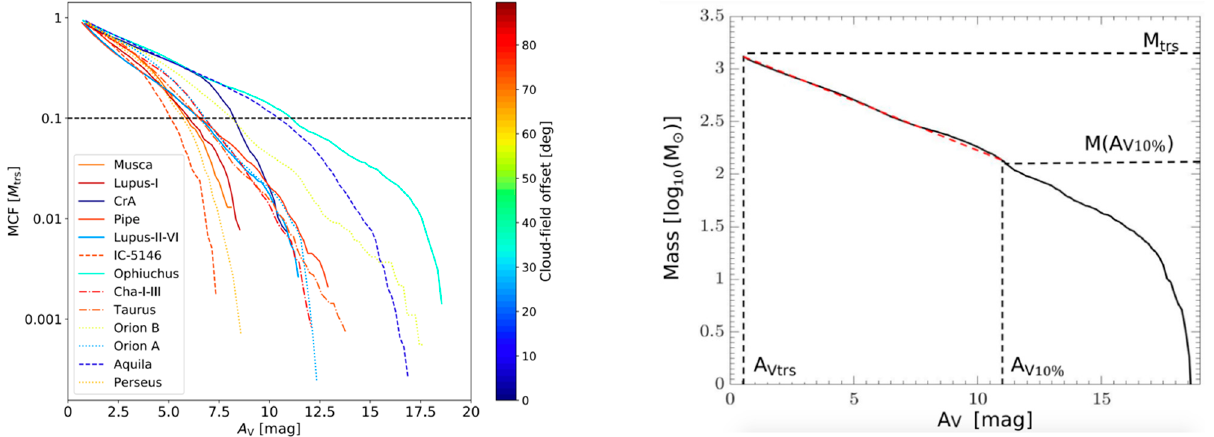
Figure 8. ( Left ): MCFs of all the Gould Belt clouds [34]. The MCFs are color coded by the cloud-field directional offsets. The starting point of each MCF is defined by the corresponding A V trs of the cloud. Perseus and Orion A/B are noted in dotted lines, because they have higher discrepancies of magnetic field directions inferred from optical and from PLANCK polarimetry data (Figure 6). Note that MCFs from smaller cloud-field offsets are in general shallower, which is further demonstrated in Figure 9. ( Right ): The definition of MCF slope illustrated with the case of Ophiuchus. The MCF slope (red dashed line) is defined by log 10 ( M trs ) − log 10 ( M Av10% ) = 1, divided by the difference between A V trs and A V 10% .